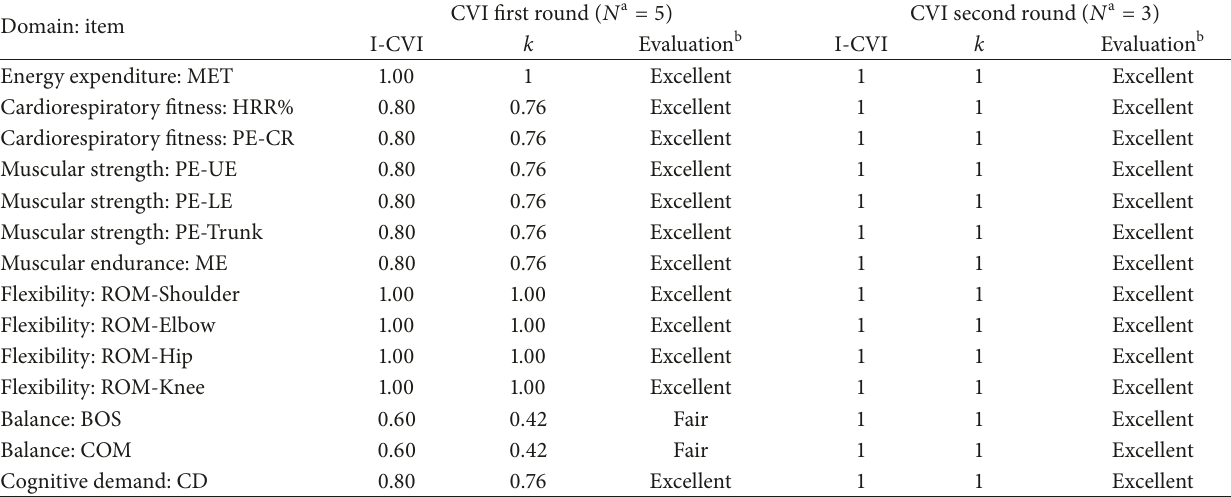
Table 1: Content validity index of Exergame Grading